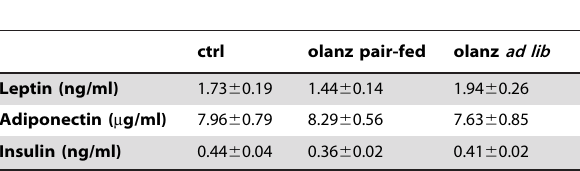
Table 1. Leptin, adiponectin and insulin plasma levels in control and olanzapine ( ad libitum and pair-fed) treated